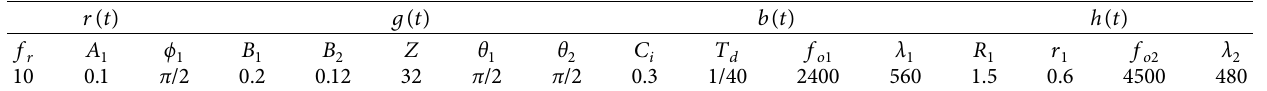
Figure 2: Flowchart of the improved VMD for rolling bearing vibration signal analysis. Table 2: Parameters of the simulated signals of case